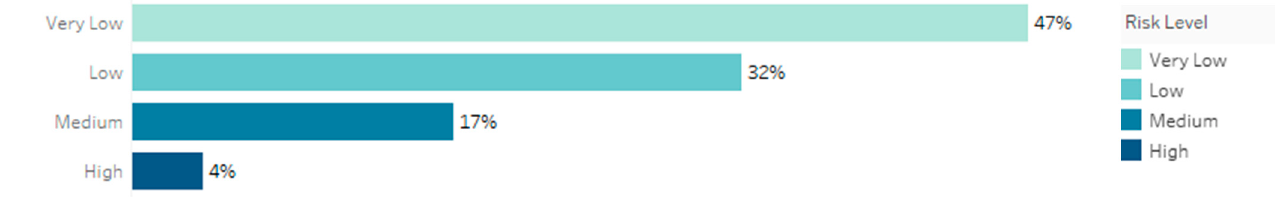
Figure 4. Percentage of injuries by IMS risk rating.